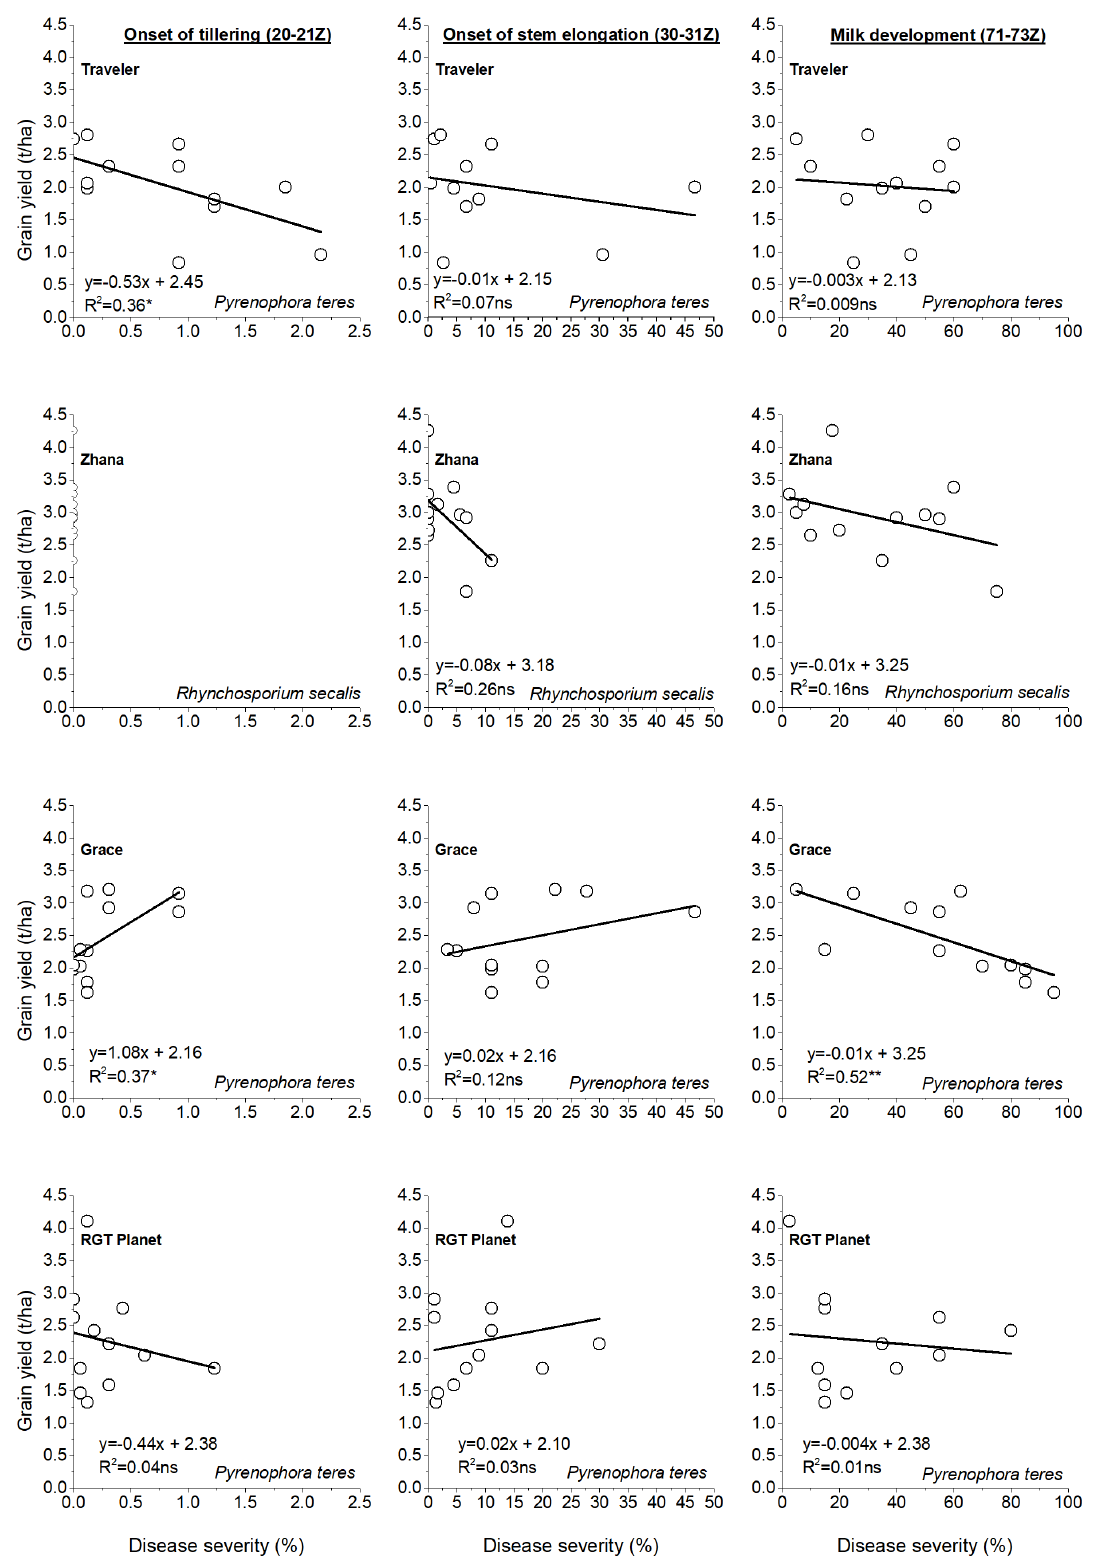
Figure 7. Relationship between grain yield and disease severity (caused by Pyrenophora teres f. teres and Rhynchosporium secalis ) assessed at di ff erent developmental stages of malt barley, when the main source of variation is the nitrogen rate. The numbers in the brackets refer to the Zadoks scale. * At p ≤ 0.05; ** at p ≤ 0.01; ns =